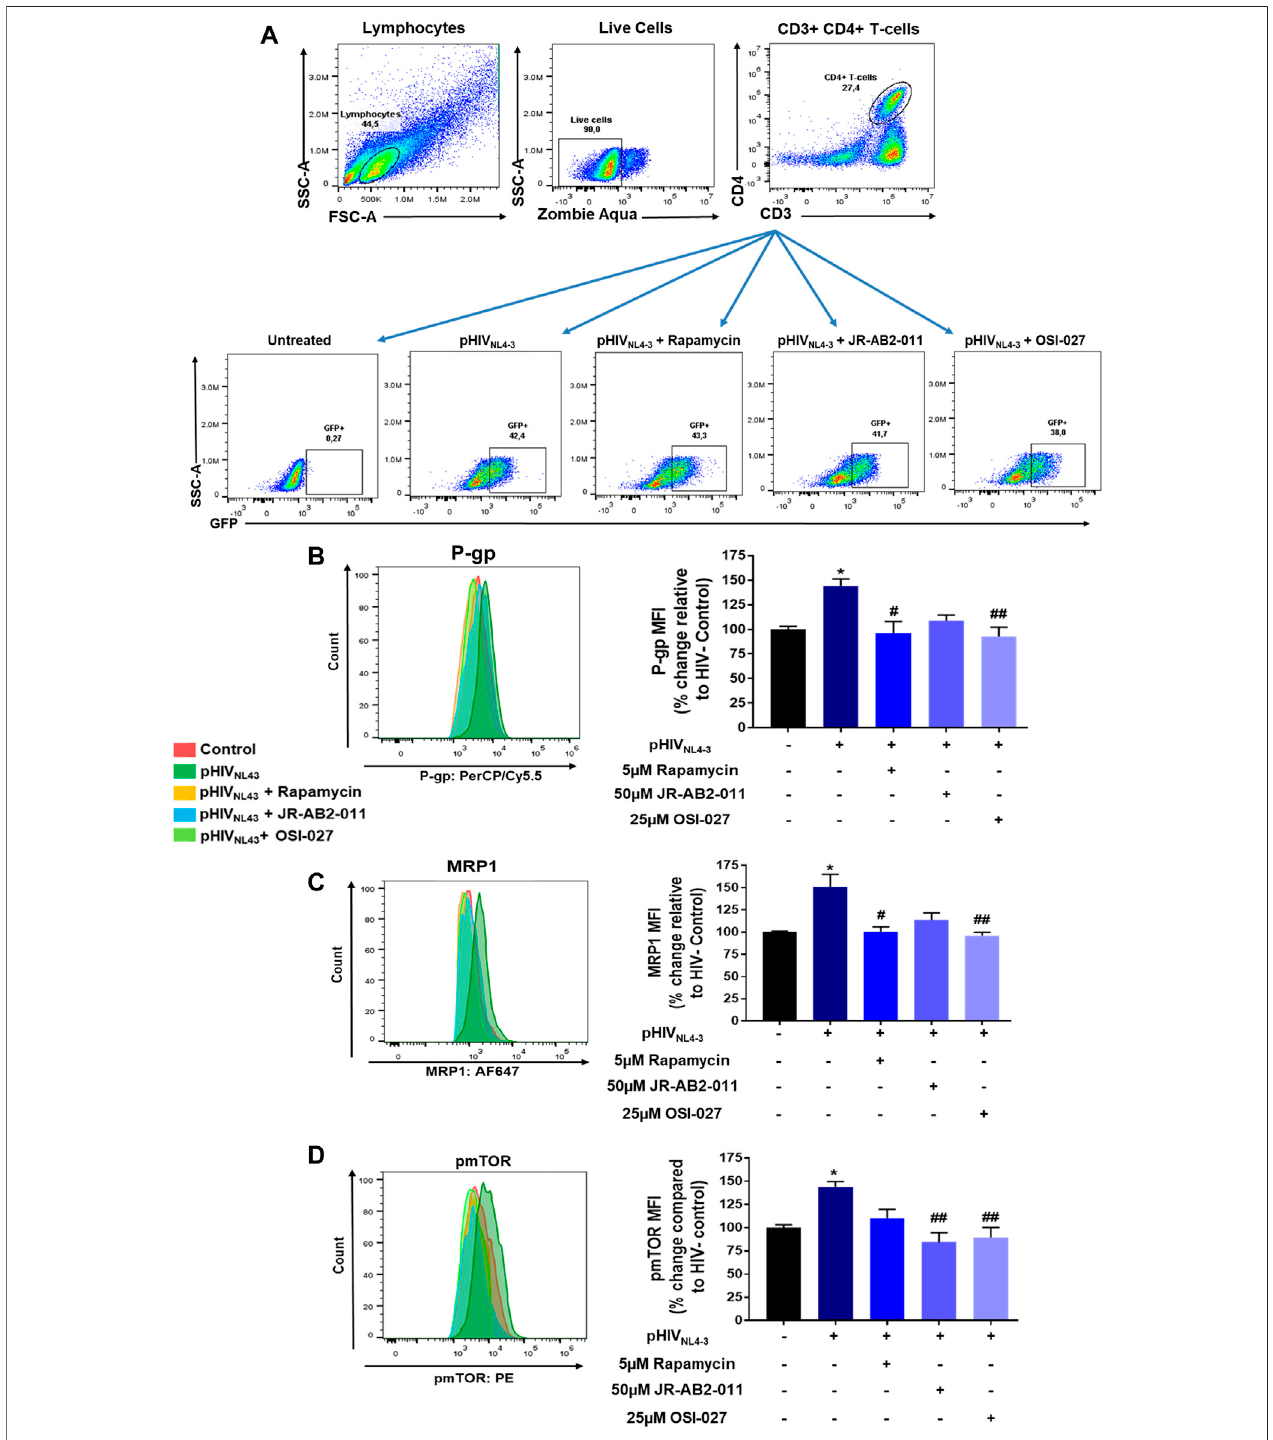
FIGURE 4 | Involvement of mTORC1 and mTORC2 in regulating pHIV NL4-3 exposed transporter expression. (A) Representative gating strategy for CD4 + T-cells isolated from PBMCs; panels from left to right show lymphocytes selected based on light scattering properties, viable (negative for Zombie Aqua) single cells were then selected for CD3 + CD4 + expression. The expression of GFP is shown in untreated, pHIV NL4-3 , rapamycin (5 µM), JR-AB2-011 (50 µM) and/or OSI-027 (25 µM) treated CD4 + T-cells after 48 h incubation time. (B – D) Representative histograms (left) and corresponding bar charts (right) are shown. Results are shown as mean percent change ± SEM in the expression (MFI) of P-gp (B) , MRP1 (C) , pmTOR (D) in untreated (vehicle control), pHIV NL4-3 , rapamycin, JR-AB2-011 and/or OSI-027 treatedCD4 + T-cells.Multiplecomparisonswereperformedusingone-wayANOVAandBonferroni ’ spost-hocanalysis; p < 0.05wasconsideredstatisticallysigni fi cant, n (cid:2) 3donors. *, statistically signi fi cantdifference compared tountreated control; #,statistically signi fi cantdifferencecomparedtopHIV NL4-3 only.*, p < 0.05; #, p < 0.05; ##, p < 0.01.